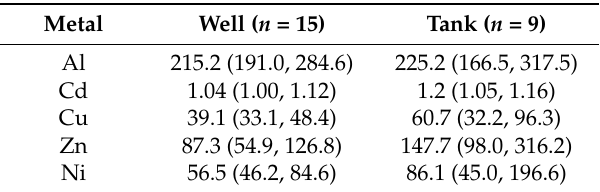
Table 4. Median and quartiles (25% and 75%) of metal concentration in well or tank waters. Concentrations are expressed in µ g L − 1